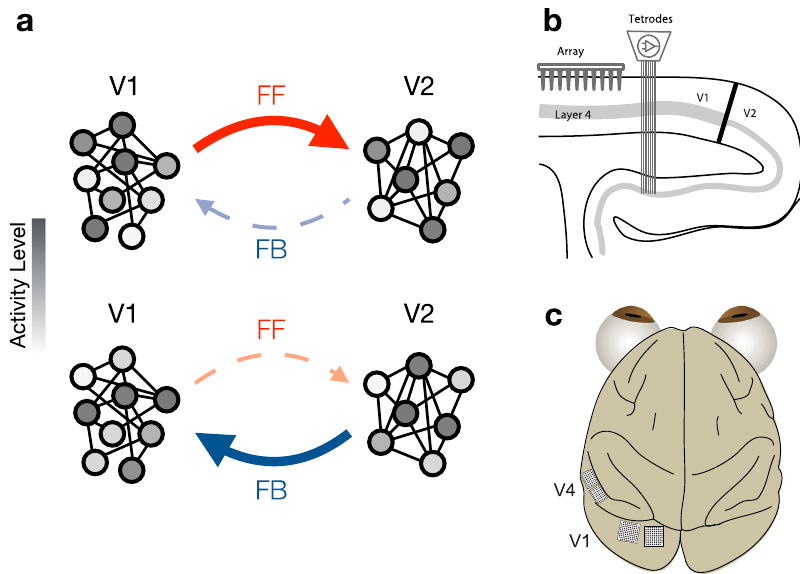
Fig. 1 Studying feedforward and feedback interactions using neuronal population activity. a Each circle represents a neuron in each area, with the shading representing the activity level of the neuron. The population activity patterns involved in feedforward signaling (top) might be distinct from those involved in feedback interactions (bottom). b Schematic showing a sagittal section of occipital cortex and the recording setup for the V1 – V2 recordings. We simultaneously recorded V1 population activity using a 96-channel array and V2 population activity using a set of movable electrodes and tetrodes. c Schematic showing an overhead view of the recording setup for the V1 – V4 awake recordings. We simultaneously recorded V1 and V4 population activity using one 96-channel and one 48-channel array in V1 and a 48-channel array in V4 in the fi rst animal, and two 96-channel arrays in V1 and two 48-channel array in V4 in the second